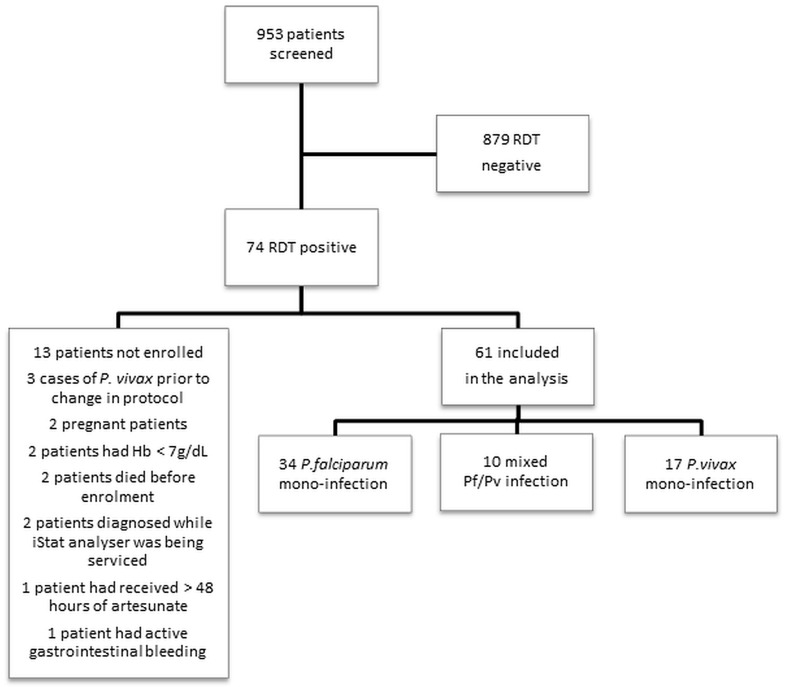
Screening and enrolment.RDT: Rapid diagnostic test. Hb: Haemoglobin, Pf: P.falciparum, Pv: P.vivax.